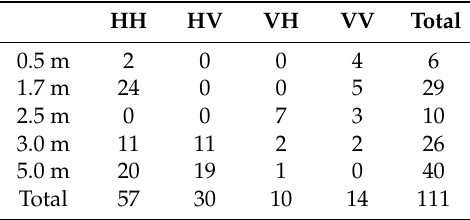
Table 1. Composition of the GF-3 SLC dataset.